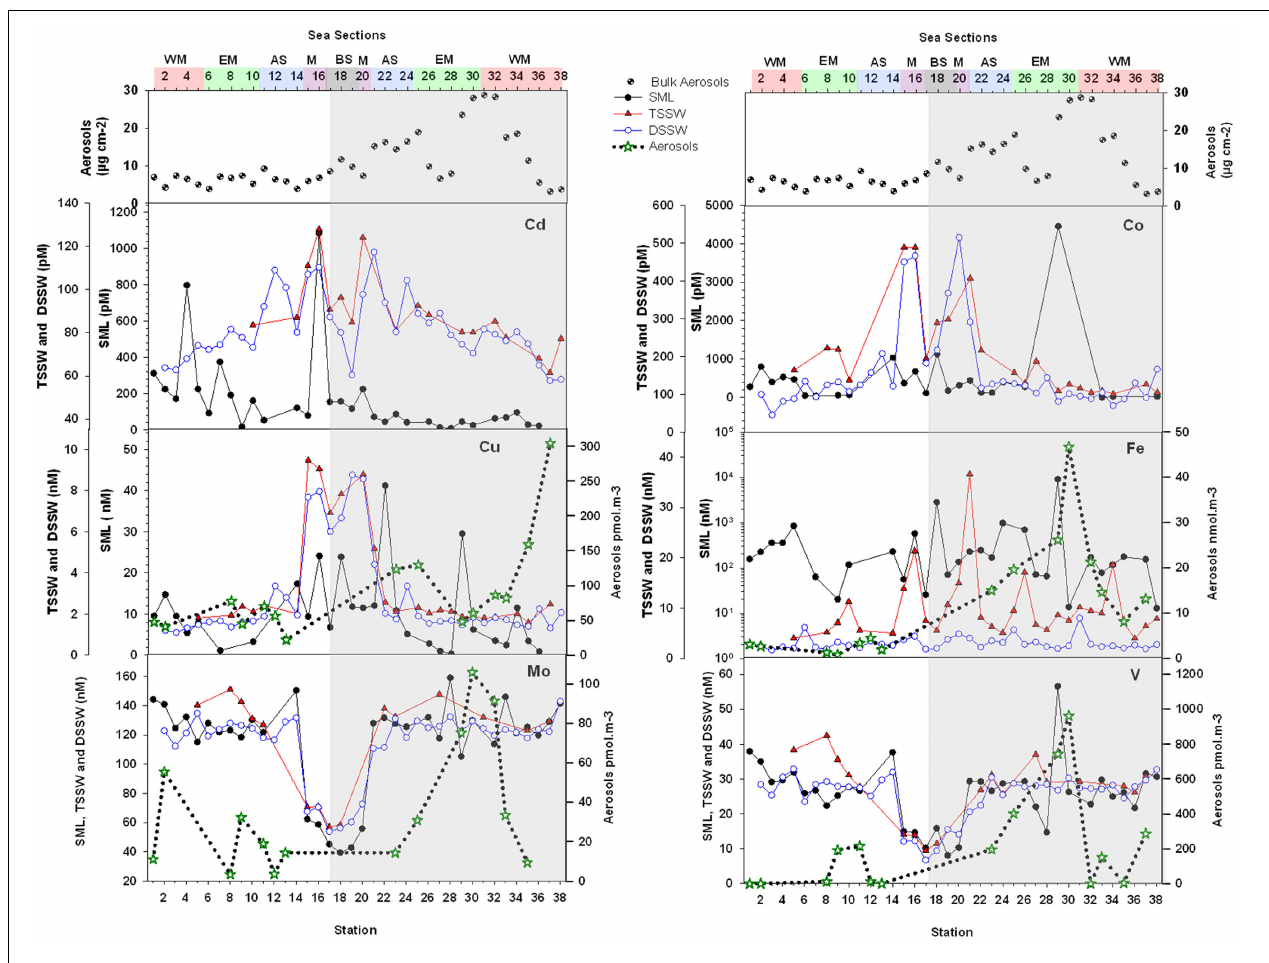
FIGURE 2 | Bulk aerosol and metal concentrations measured in the different water-column compartments. SML, surface micro-layer: black dots; TSSW, total subsurface water: red triangles; DSSW, dissolved subsurface water: open blue dots; and aerosols, black-white dots. Shaded